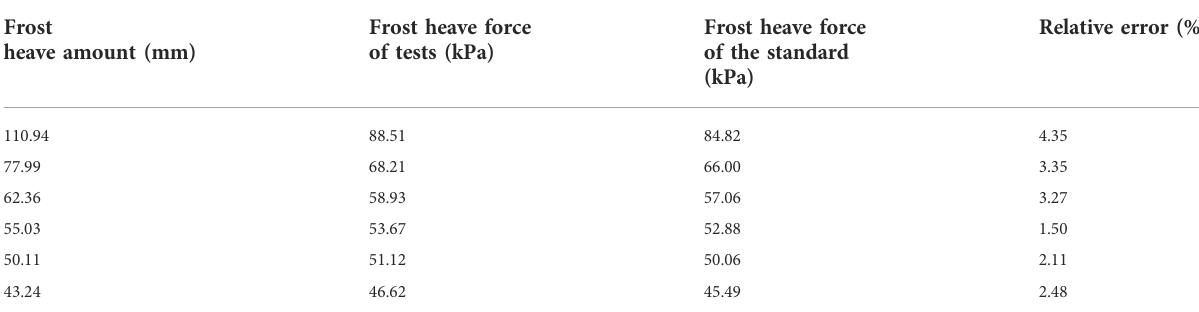
TABLE 4 Comparison of horizontal frost heave force. Frost heave amount (mm)